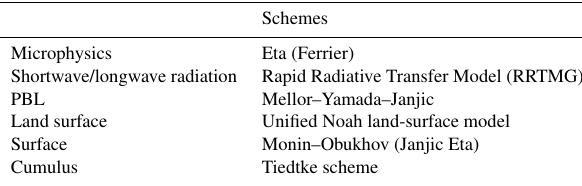
Table 1. WRF model schemes and